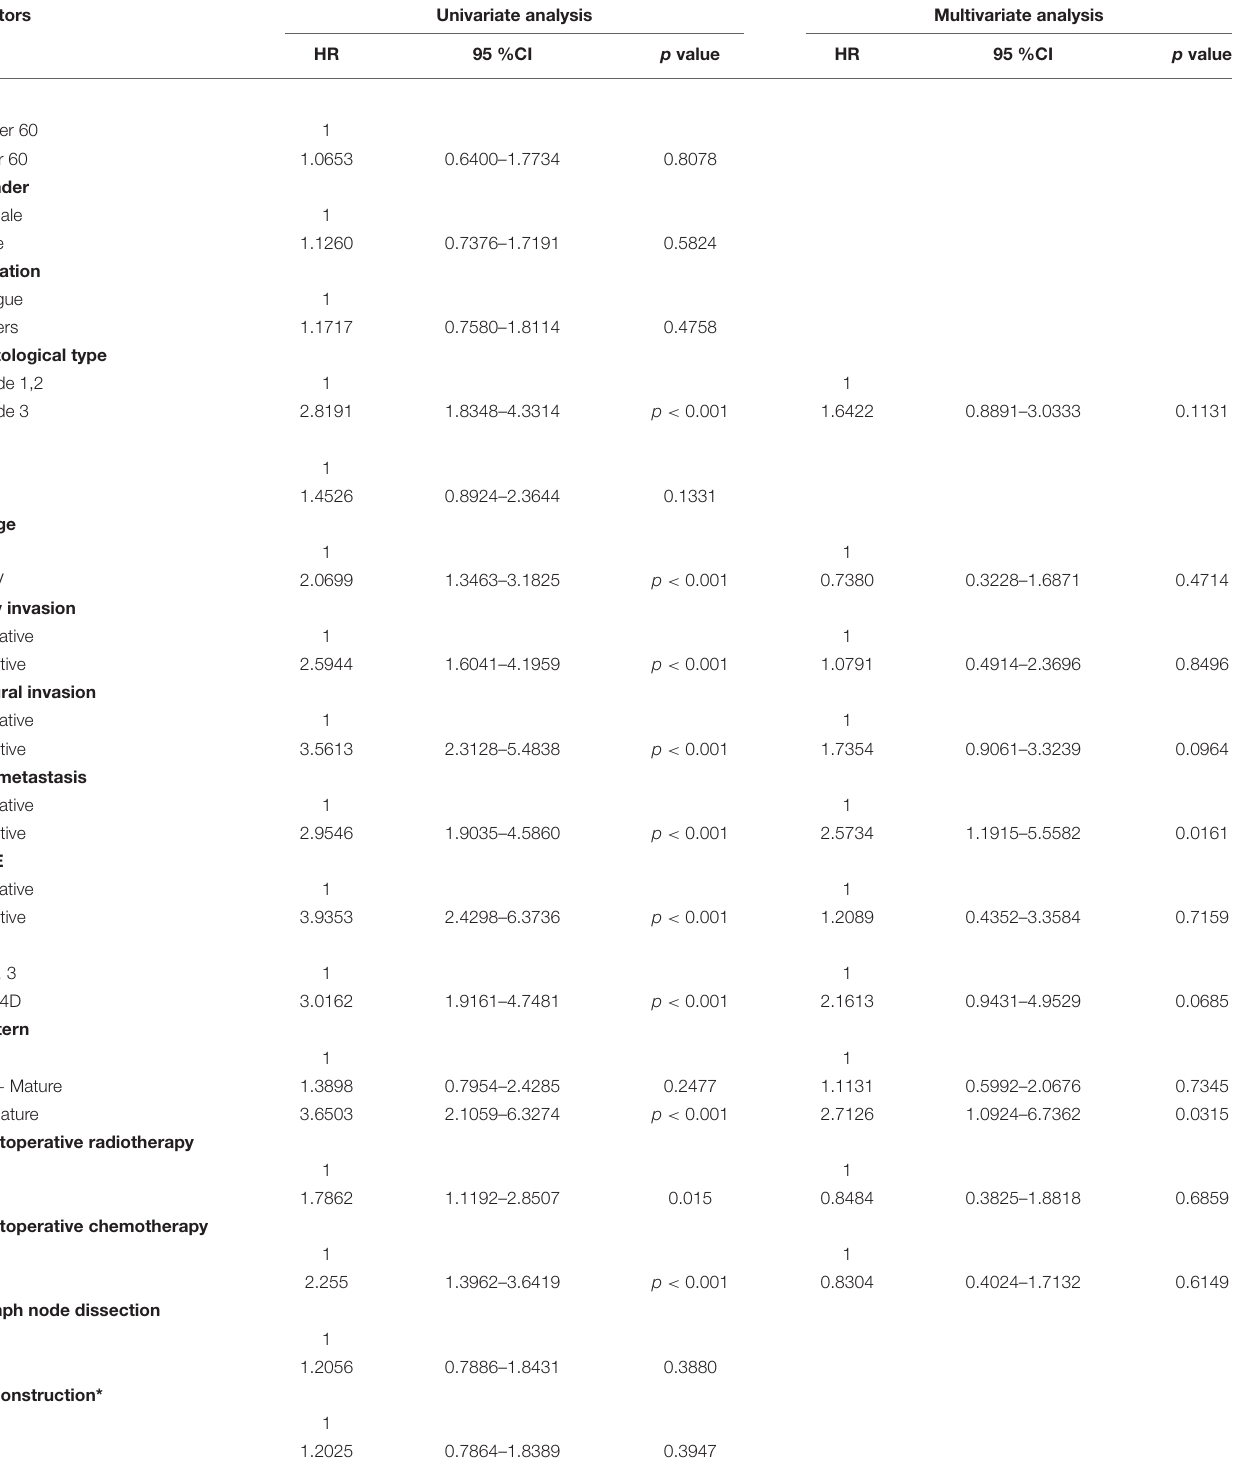
TABLE 2 | Univariate and multivariate analyses of relapse-free survival. Factors Univariate analysis Multivariate